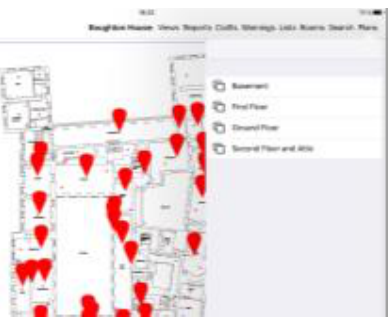
Figure 3 Screenshot of docu-tools. Boughton